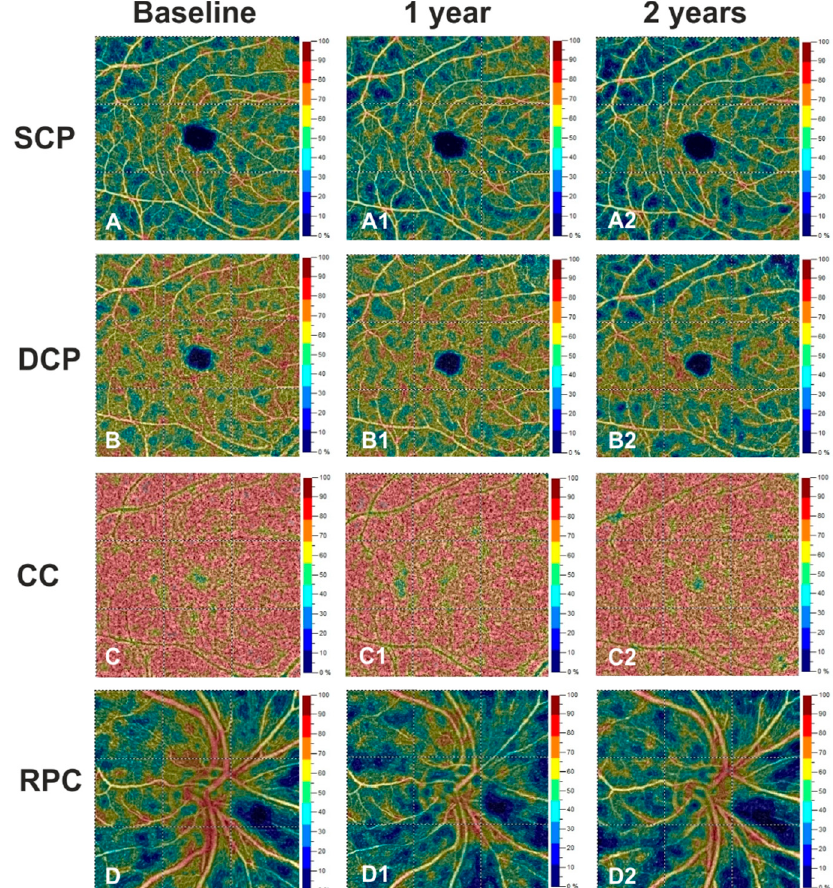
Figure 1. Right eye of a case patient with IDE (27 years-old male) shows a marked vessel density reduction for superficial capillary plexus (SCP) ( A2 ), deep capillary plexus (DCP) ( B2 ) and radial peripapillary capillary plexus (RPC) ( D2 ) at years 2 respect to baseline ( A , B , D ) and year 1 ( A1 , B1 , D1 ). VD in the choriocapillaris (CC) did not change over the follow-up ( C , C1 , C2 ).